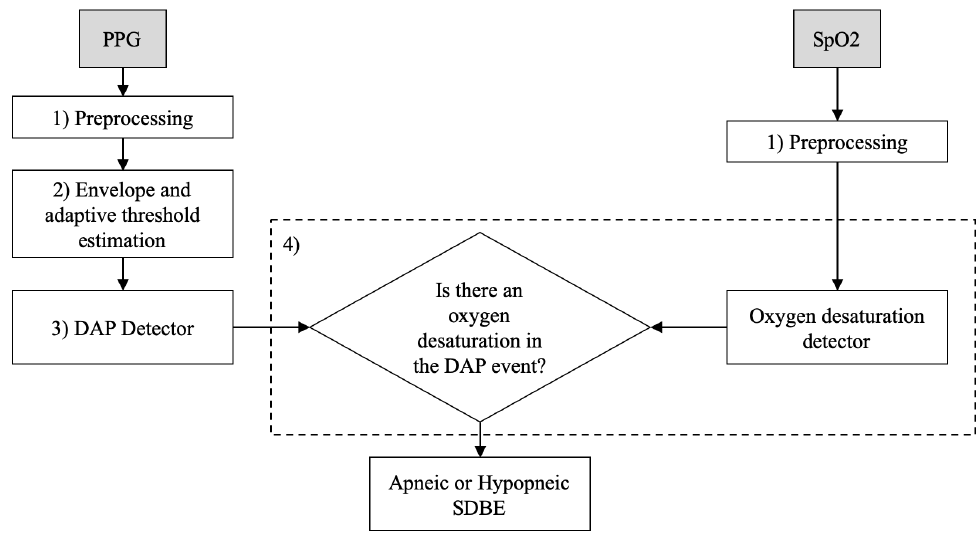
Figure 5. Apneic and hypopneic events detection